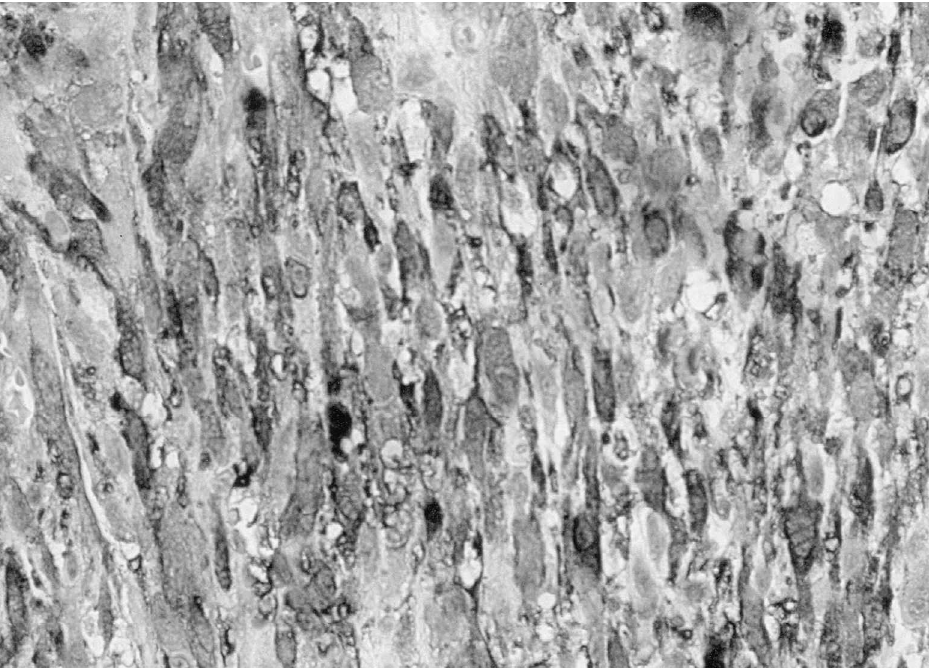
Fig. 2. On immunohistochemical stains, strong positivity for smooth muscle antigen (SMA, 100) can be